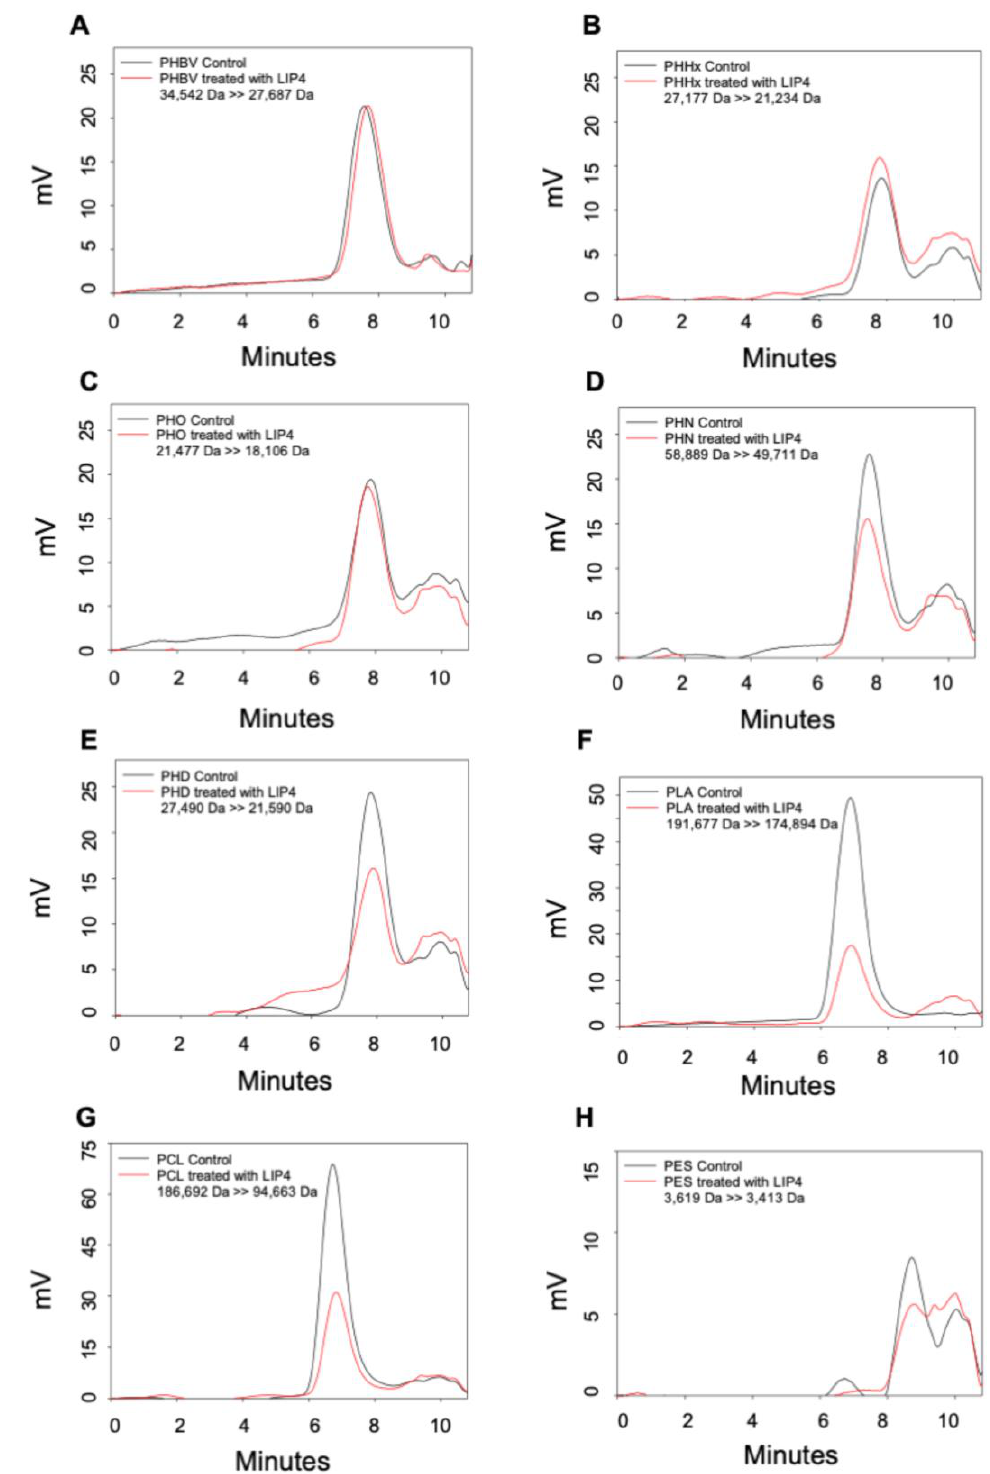
Figure 9. Gel Permeation Chromatography (GPC) analyses of LIP4. The overlay of chromatograms of different polymer substrates before (control = black line) and after LIP4 treatment (red line). ( A ) PHBV; ( B ) PHHx; ( C ) PHO; ( D ) PHN; ( E ) PHD; ( F ) PLA; ( G ) PCL; and ( H ) PES. Numbers indicate the change in polymer molecular weight before and after treatment. mV, the HPLC Refractive Index Detector records the signa intensity in millivolts.